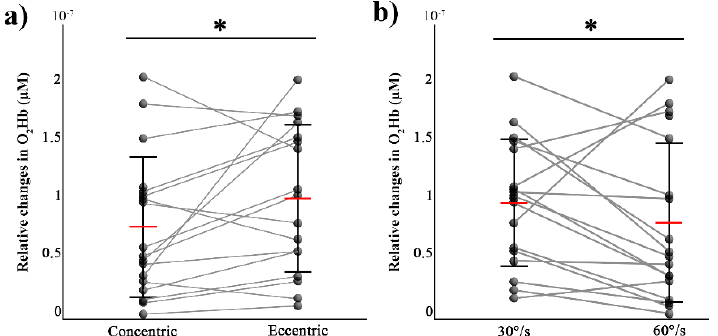
Figure 4. Changes for each participant (black circles) and mean (red horizontal line) values ( ± SD) of the peak values of O 2 Hb over the contralateral M1 during concentric and eccentric movements ( a ) and for two angular velocities (( b ), 30°/s compared to 60°/s). * p < 0.05.